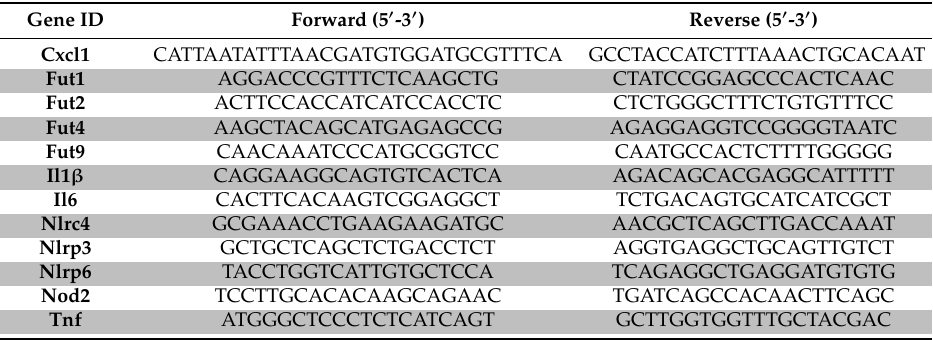
Table 2. SybrGreen primer sets used in QPCR experiments for rat